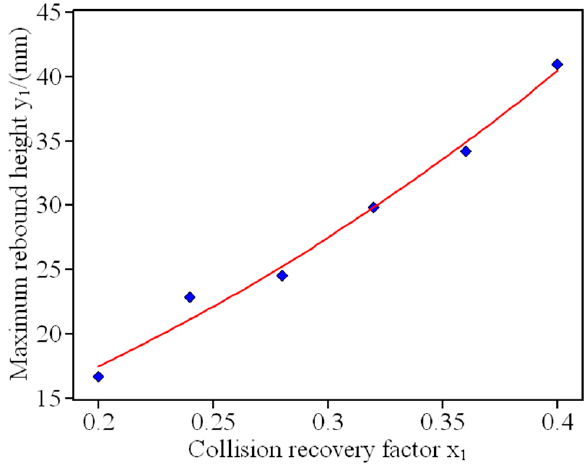
Figure 4. The fitting curve of maximum springing height and restitution coefficient in the simulation experiment.